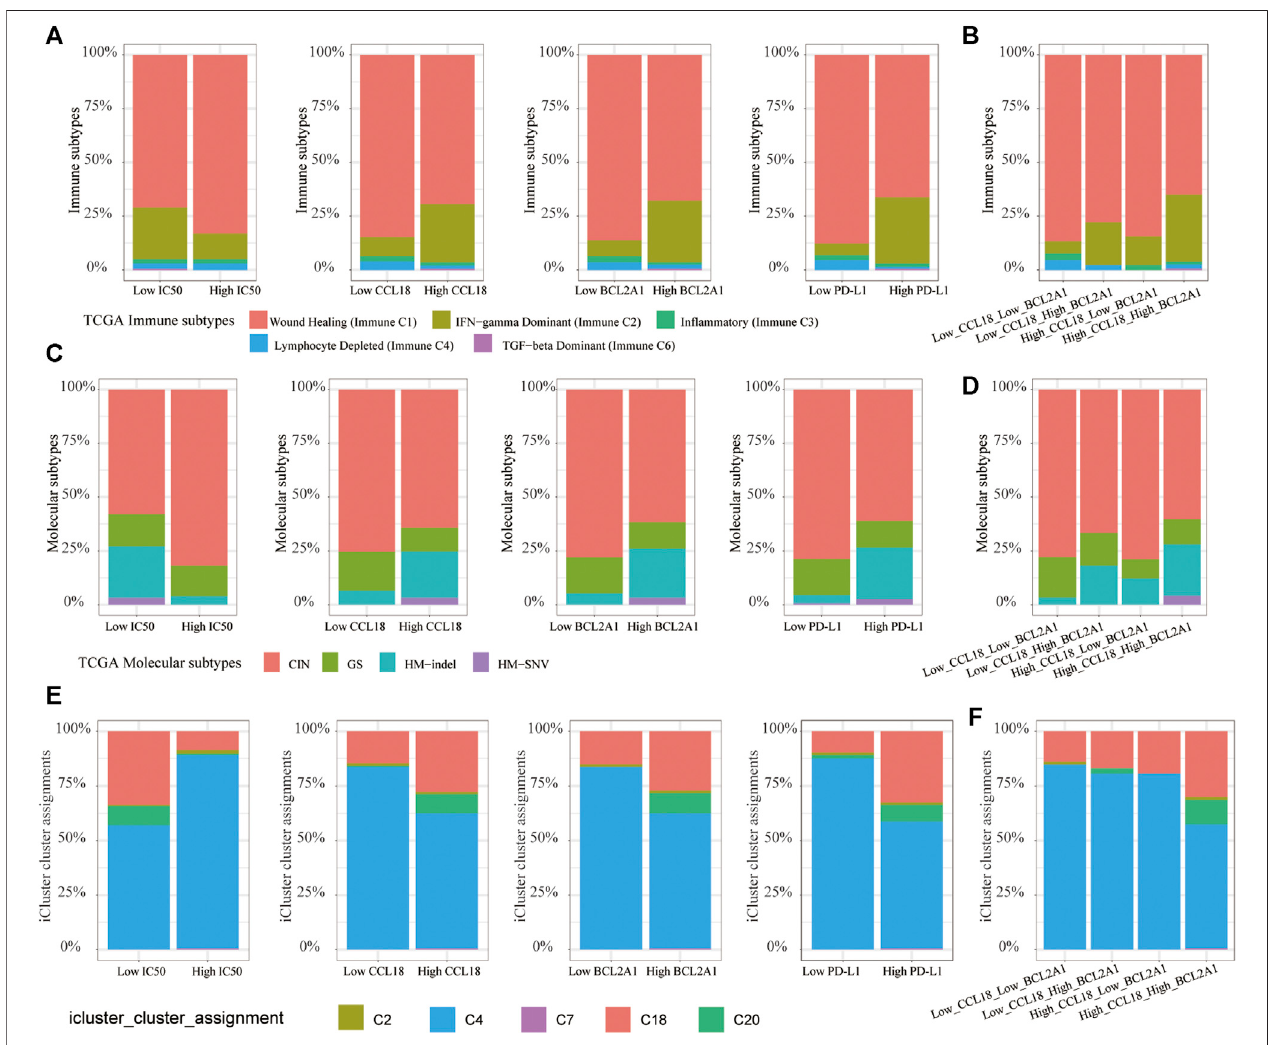
FIGURE 15 | TCGA-COAD subtype analysis. (A , B) The proportion of immune C2 and C6 increased signi fi cantly in the low-IC50 group, high CCL18 or BCL2A1or PD-L1 group, and High_CCL18_High_BCL2A1 group. (C – F) The low-IC50 group, high group of CCL18 or BCL2A1 or PD-L1 and Low_CCL18_Low_BCL2A1 group had a higher proportion of HM-indel, HM-SNV, C18 and